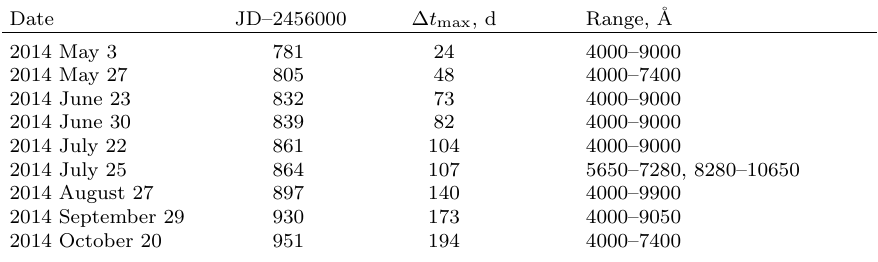
Table 2. Spectroscopic